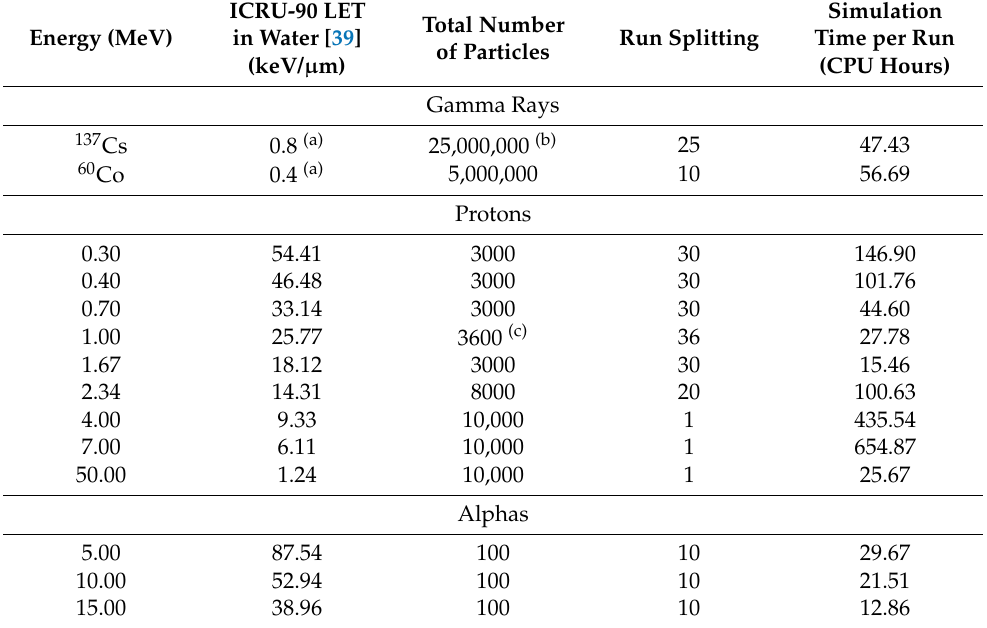
Table 3. The energies of 137 Cs, 60 Co, protons, alphas, and the corresponding LET in water, number of particles, number of runs, and simulation time. Simulation ICRU-90 LET Total Number Run Splitting Time per Run Energy (MeV) in Water [39] of Particles (CPU Hours) (keV/ µ m) Gamma